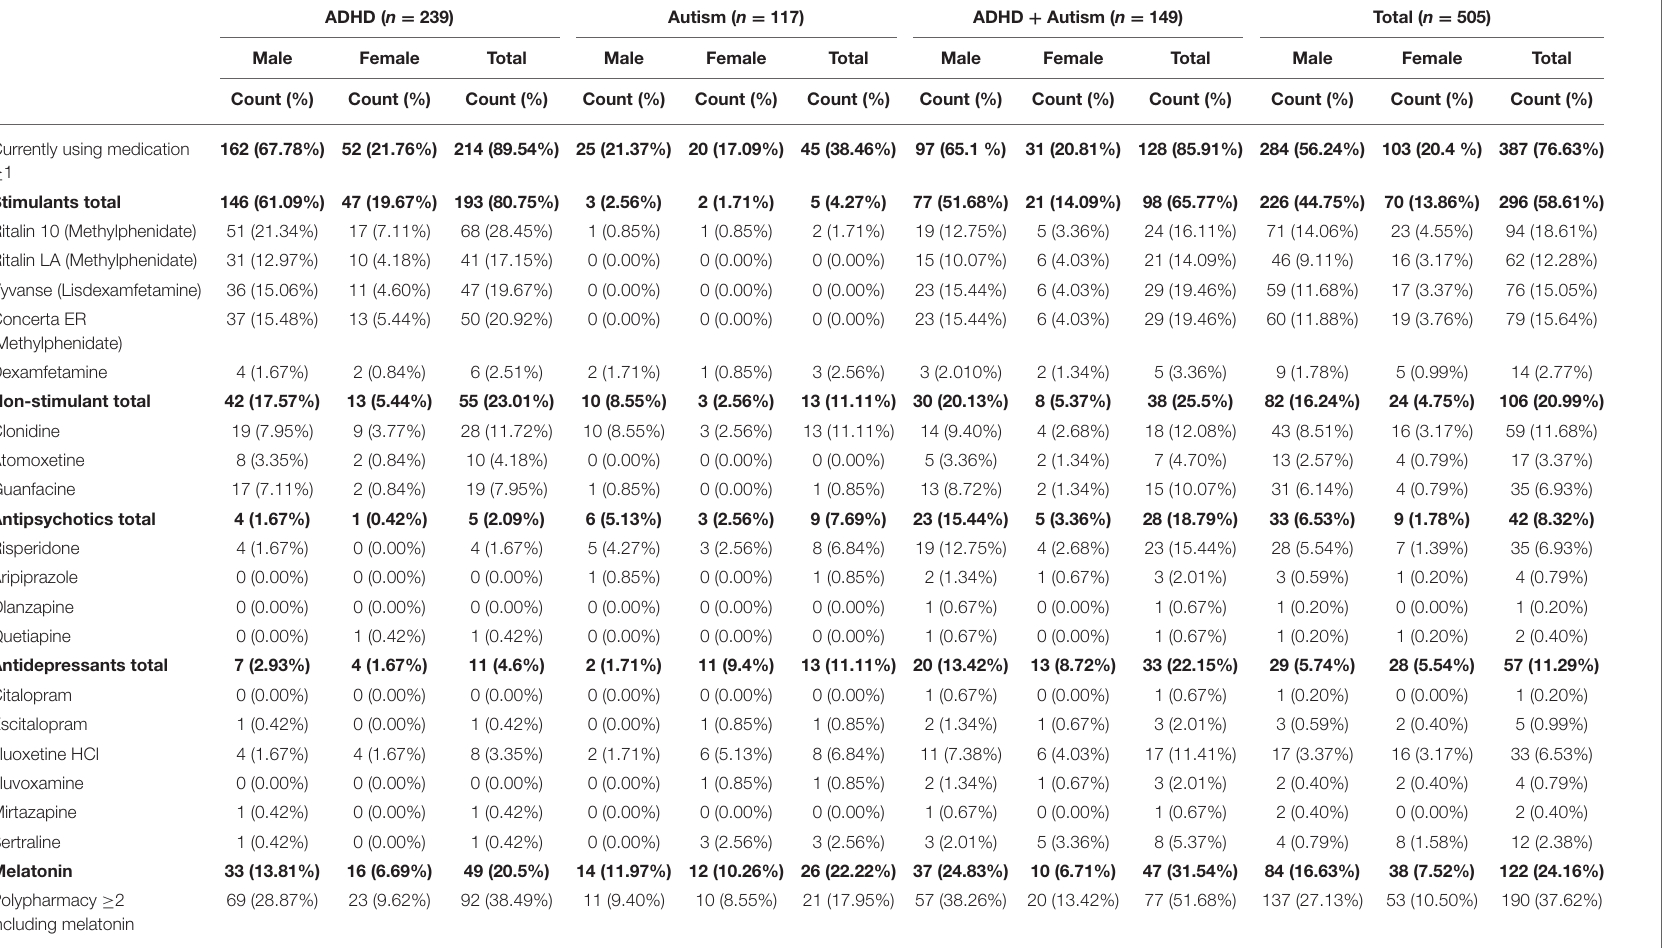
Percentages were calculated with respect to total n within each diagnostic group, e.g. n = 239 for ADHD group, N = 505 for the total sample. Polypharmacy ≥ 2 including melatonin, concurrent use of two or more medications, including melatonin. Bold values indicate the medication class